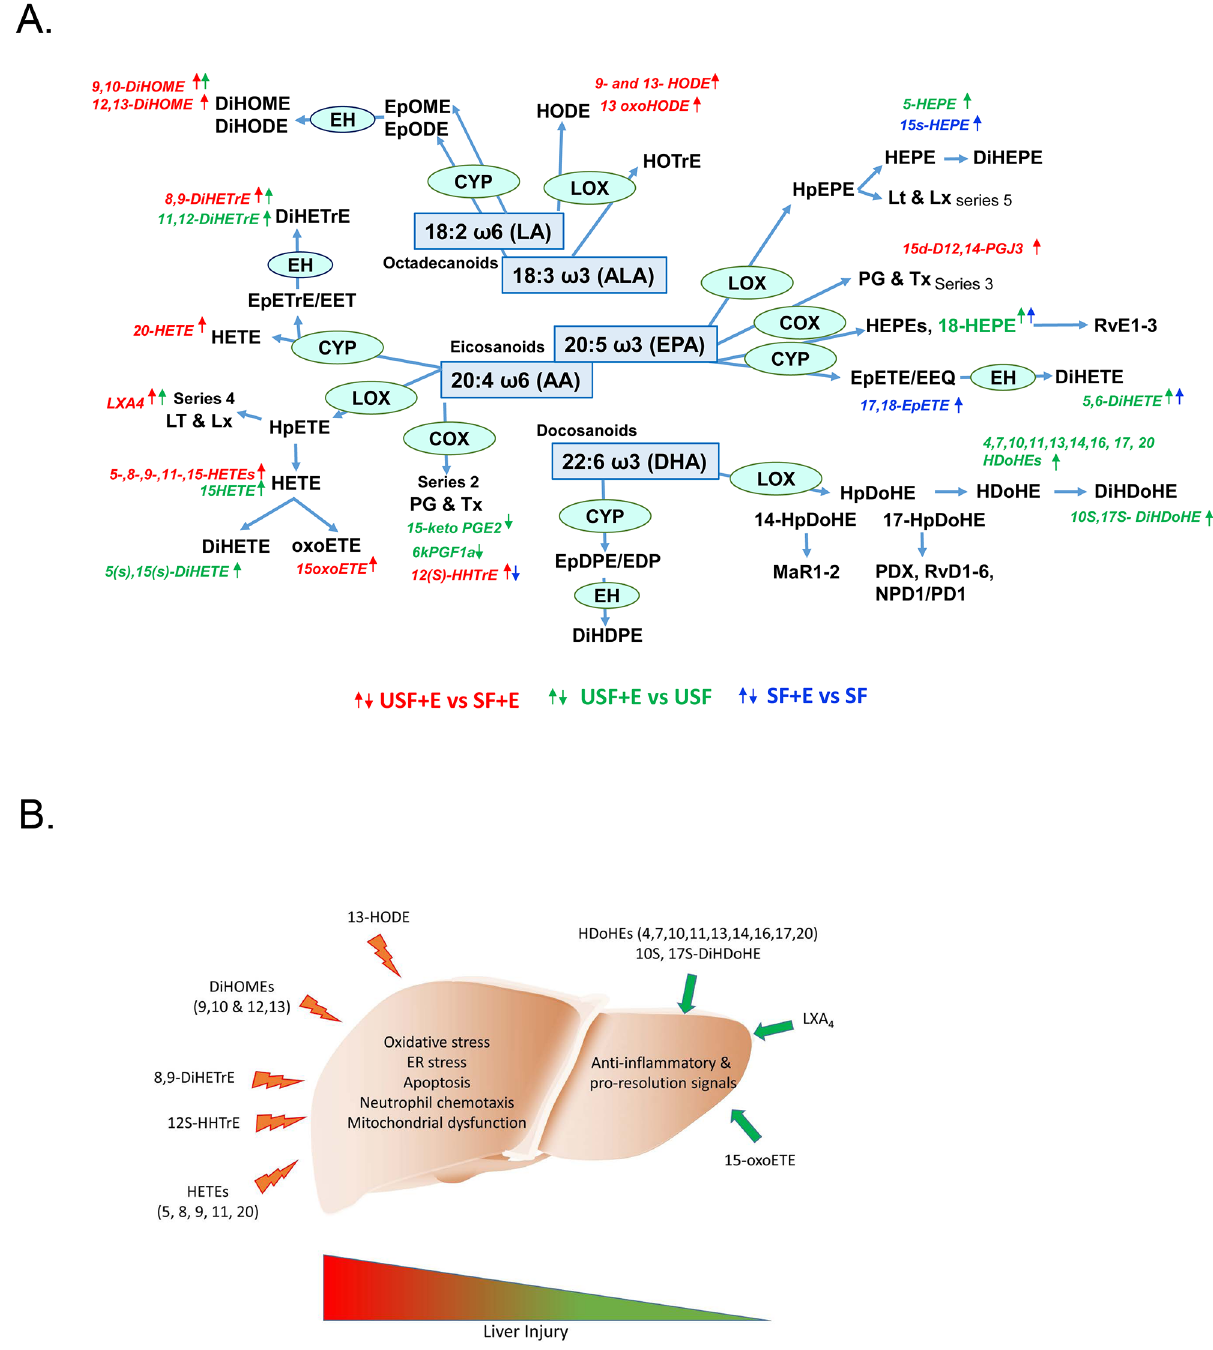
Fig 10. EtOH-mediated alterations in liver oxylipins. A: Summary of changes in hepatic ω-6 and ω-3 PUFA-derived oxylipins in response to EtOH exposure. B: A working model wherein multiple ω-6-derived oxylipins (to the left) facilitate liver injury via distinct mechanisms. The deleterious effects of these oxylipins outweigh the benefits of anti-inflammatory and pro-resolving bioactive lipid mediators (to the right), and tips the balance towards liver damage. Abbreviations are listed in S4 and S6 Tables.